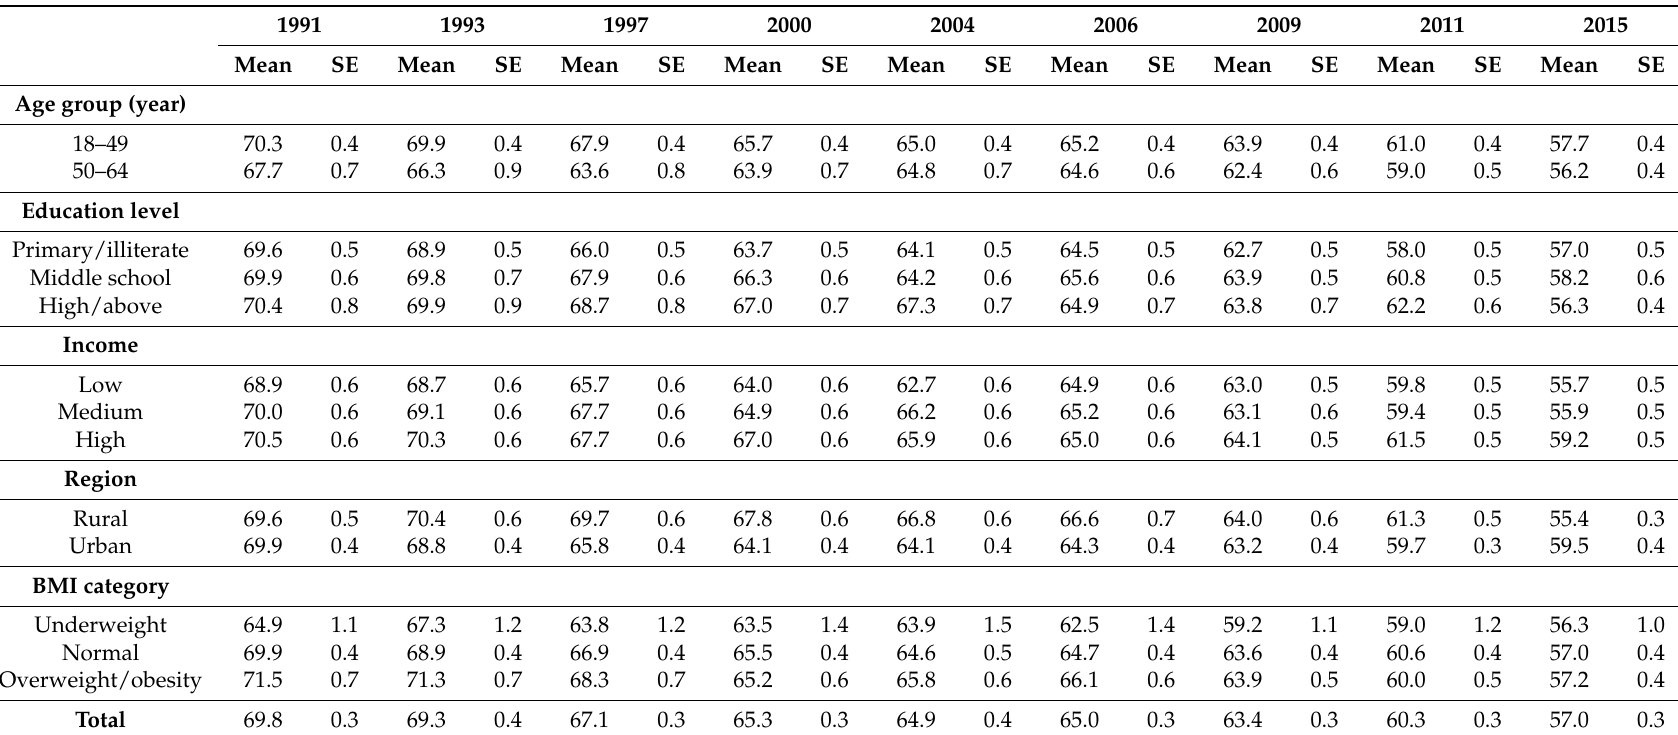
Table 5. Daily protein intake (g), by age, education, work status, income and geographical region, in Chinese women from 1991 to 2015 1,2